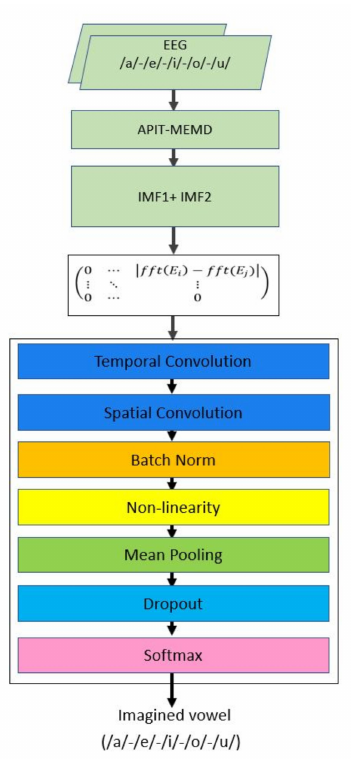
Figure A1. Reference architectures with CNN Shallow